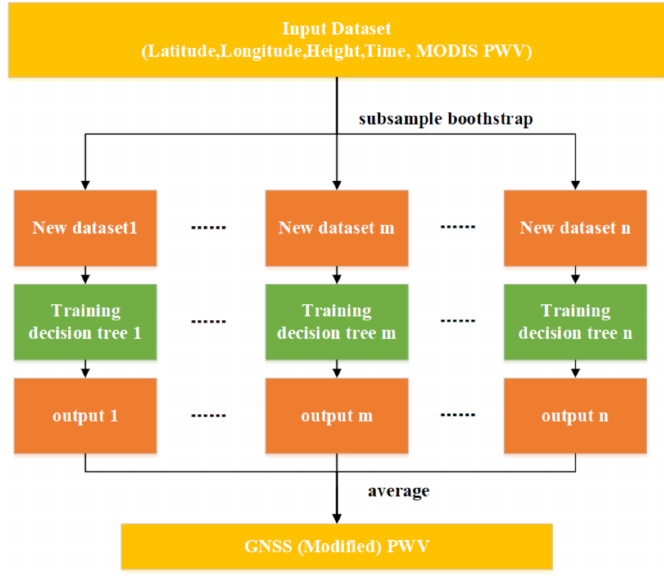
Figure 3. MODIS–GNSS PWV RF calibrate